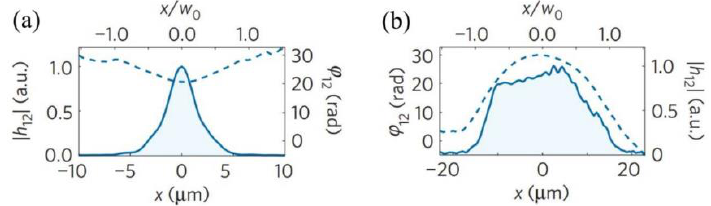
Figure 15. Retrieved amplitude | h 12 | (solid curve) and phase profile φ 12 (dashed curve) of the 12th harmonic in the focal plane ( a ) for ROM case (peak intensity on target is I L ~ 7 × 10 18 W/cm 2 , main beam waist w 0 = 6.2 µm and appropriately long plasma density gradient [118]) and ( b ) for CWE case (peak intensity on target is I L ~ 3 × 10 17 W/cm 2 , main beam waist w 0 = 14.4 µm and appropriately short plasma density gradient [118]). x is the focal plane coordinate. Figure from Ref. [86]. The measured spatial phase shows opposite curvature in the source plane in the two scenarios.